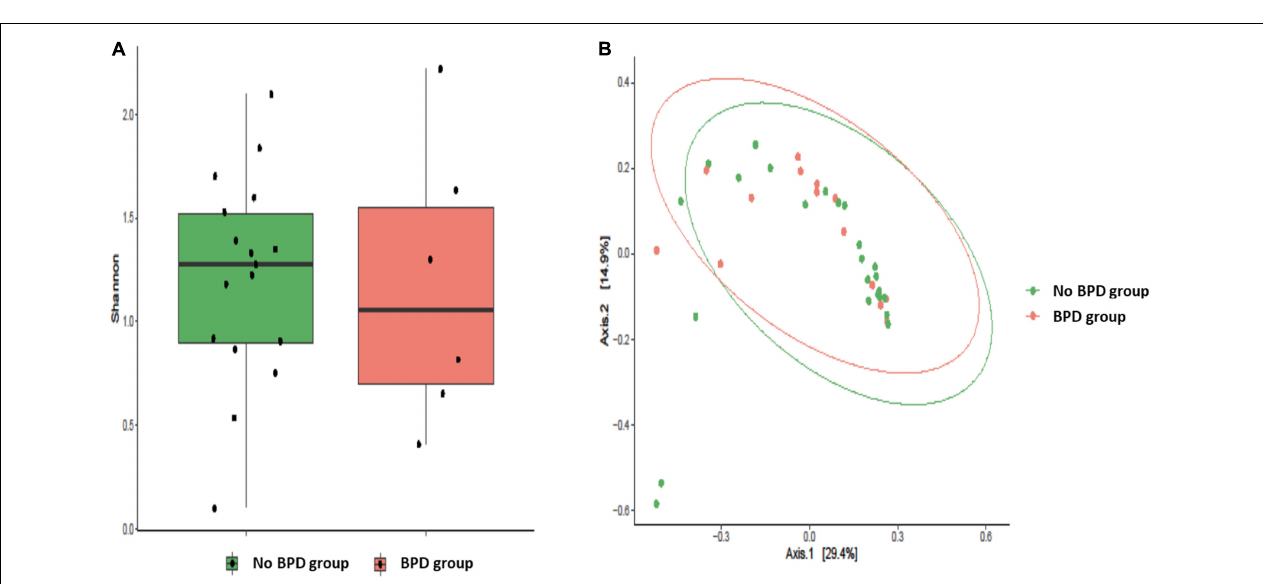
FIGURE 4 | Relative abundances of bacterial taxa composing the lung bacterial communities in hospitalized newborns. For each sample of the BPD and noBPD groups, proportions for major phyla (A) and major genera (B) were computed, normalized, and presented as stacked bar plots. The statistical significance at a P -value of ≤ 0.05 was assessed using the Mann–Whitney U -test.